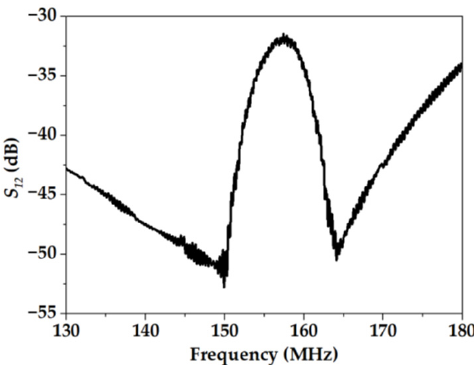
Figure 7. The frequency dependence of the S 12 parameter (insertion loss) for device #2 after plasma cleaning.